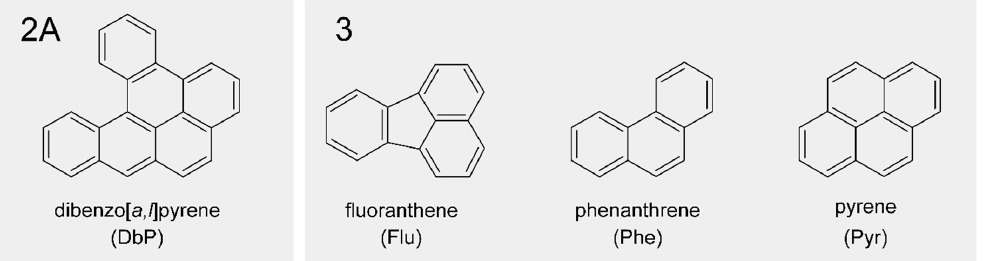
Figure 1. Chemical structures of polycyclic aromatic hydrocarbons (PAHs) used in this study in alphabetical order. PAHs are clustered additionally according to their International Agency for Research on Cancer (IARC) classification. Group ( 1 ): carcinogenic to humans; group ( 2A ): probably carcinogenic to humans; group ( 2B ): possibly carcinogenic to humans; group ( 3 ): not classifiable as to its carcinogenicity to humans [22].